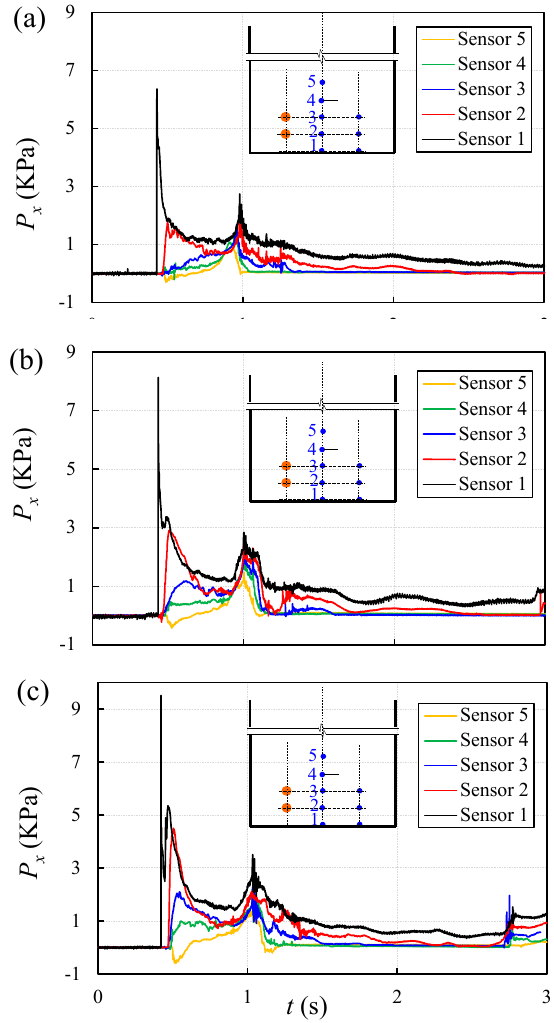
Figure 7. Time-history of the horizontal dynamic pressure at different elevations along the vertical wall: ( a ) H = 200 mm; ( b ) H = 250 mm; ( c ) H = 300 mm.